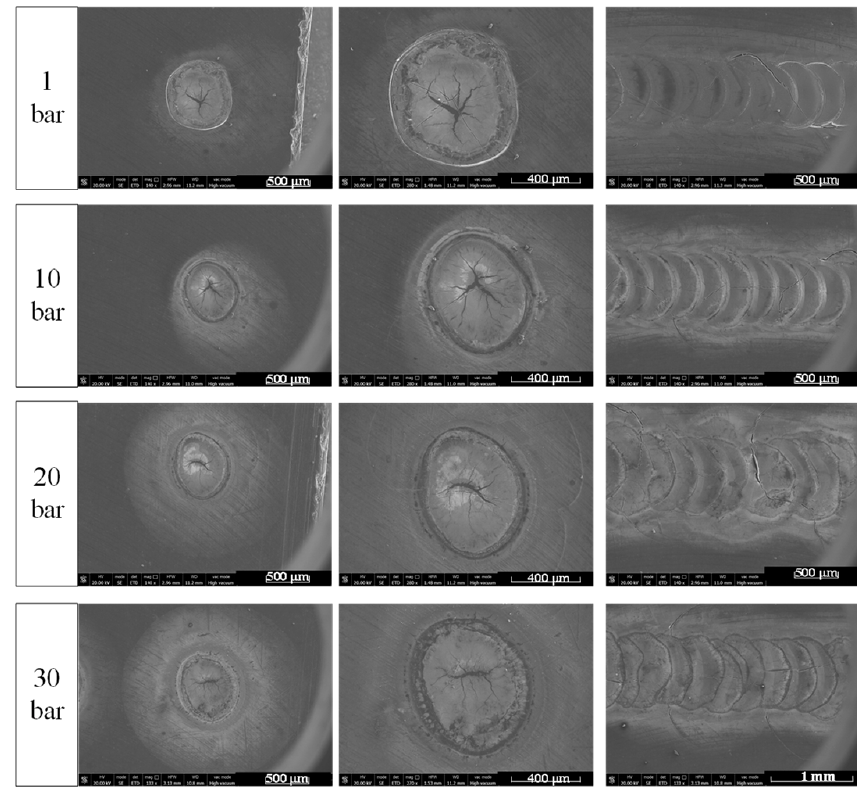
Figure 3. Macroscopic effect diagram of beryllium laser melting under different pressures.